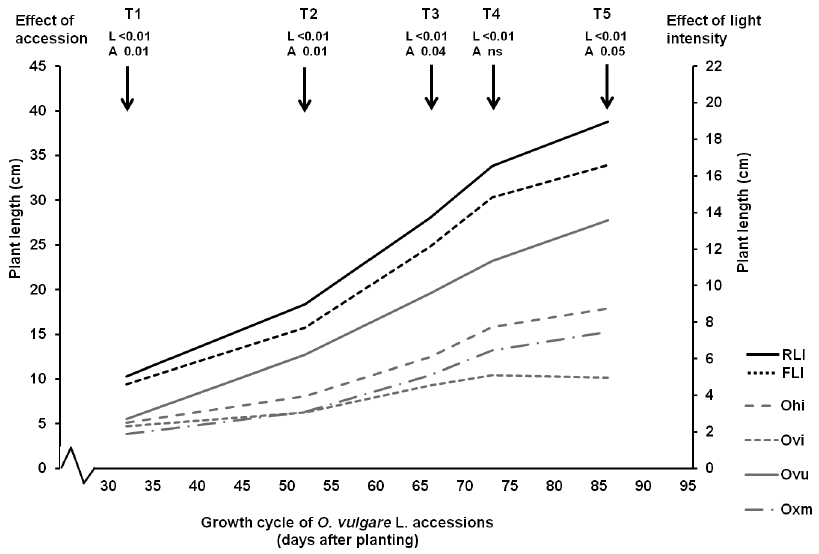
Fig. 3: Plant length of Origanum vulgare L. accessions under RLI and FLI conditions during the growing season. Ovu: Origanum vulgare L. ssp. vulgare , Ohi: Origanum vulgare L. ssp. hirtum (Link) letswaart, Ovi: Origanum vulgare L. ssp. viride (Boiss.) Hayek, Oxm: Origanum vulgare L. ssp. viride (Boiss.) Hayek × O. majorana L., T1 – T5: time of measurement (days), L: Light (p value), A: Accession (p value), RLI: reduced light intensity, FLI: full light intensity.